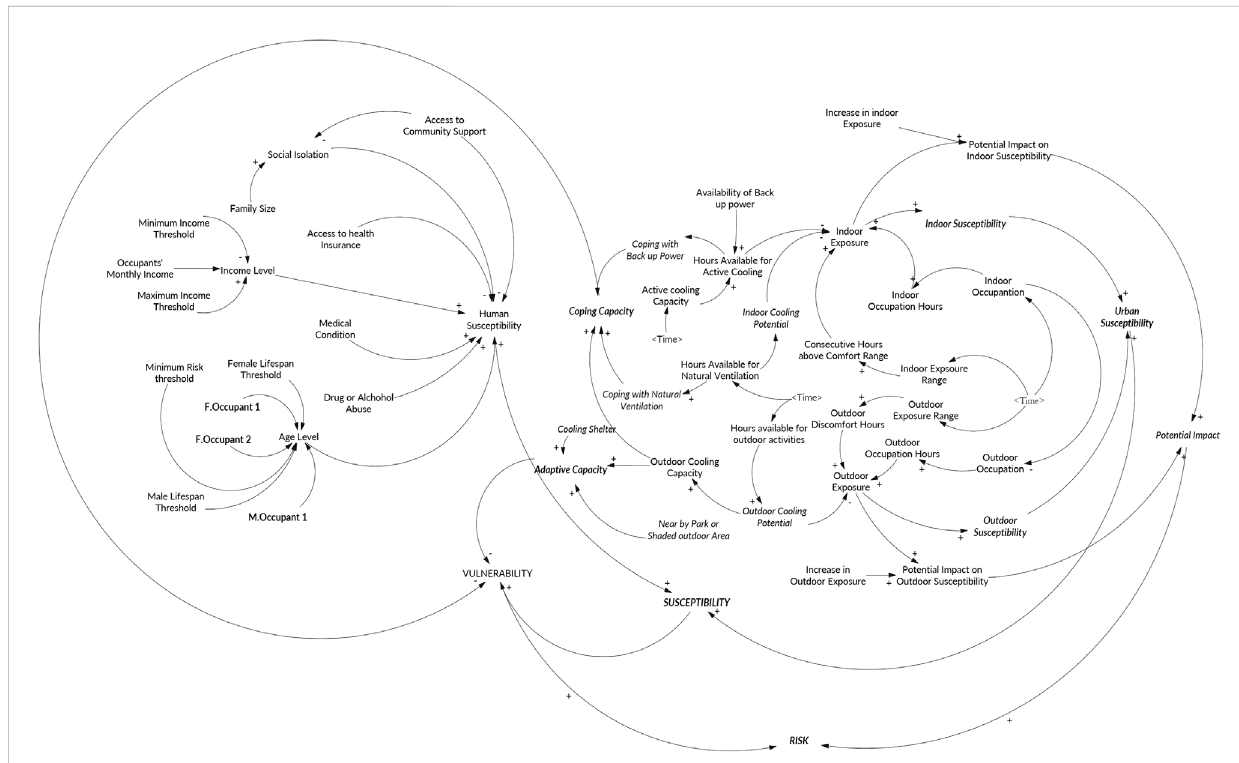
FIGURE 3 Causal loop diagram between heat exposure, susceptibility, and adaptive capacity in heat vulnerability